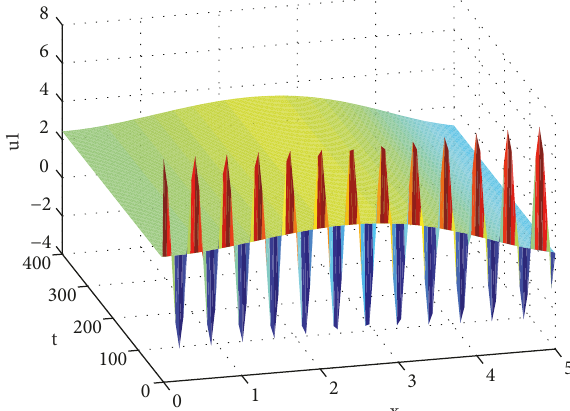
Figure 3: Dynamic behavior of solution V 1 .